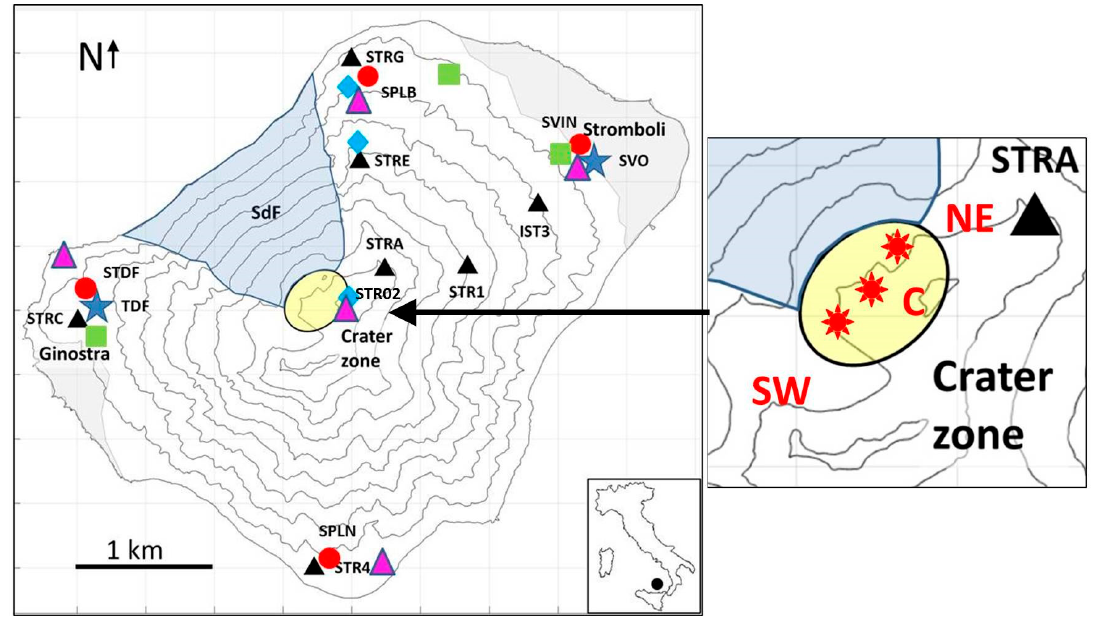
Figure 1. Left: Map of Stromboli island (and its location in southern Italy, inset) with the Stromboli and Ginostra villages, the “Sciara del Fuoco” depression (SdF), and the crater zone (yellow oval). The black triangles indicate the position of the seismic stations; the blue stars indicate the position of the strainmeters; the red circles are the GPS stations; the green squares are the tiltmeters; the blue diamonds are video-cameras, and the magenta triangles are the geochemical stations. Right: The crater zone with the main vent regions (red stars): Northeast (NE), central (C) and southwest (SW).